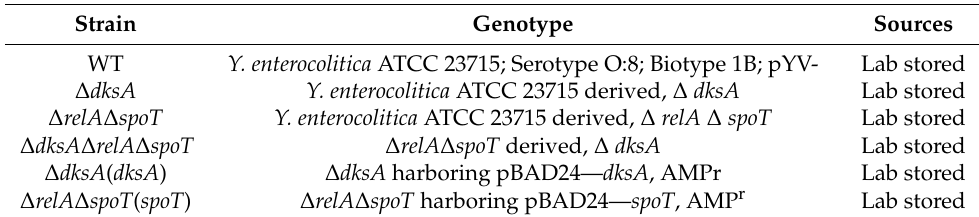
Table 2. Strains and plasmids used in this